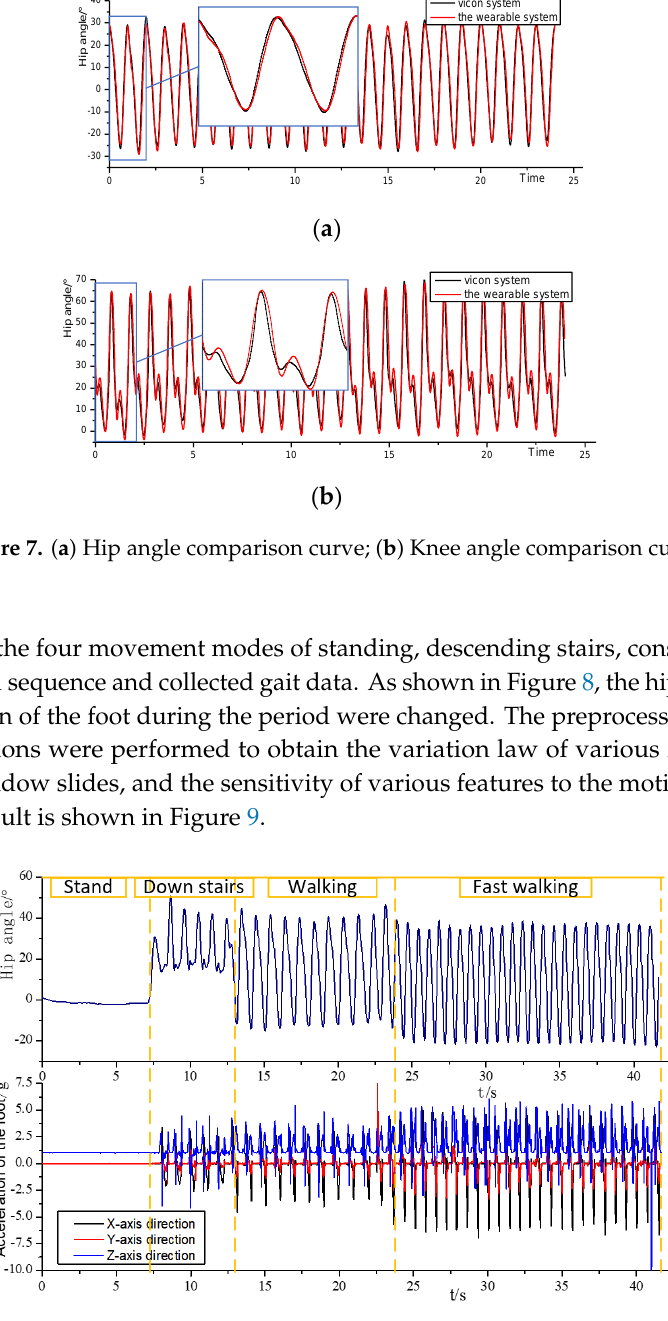
Figure 8. Hip joint angle and changes in the three-axis acceleration of the typical behavior.